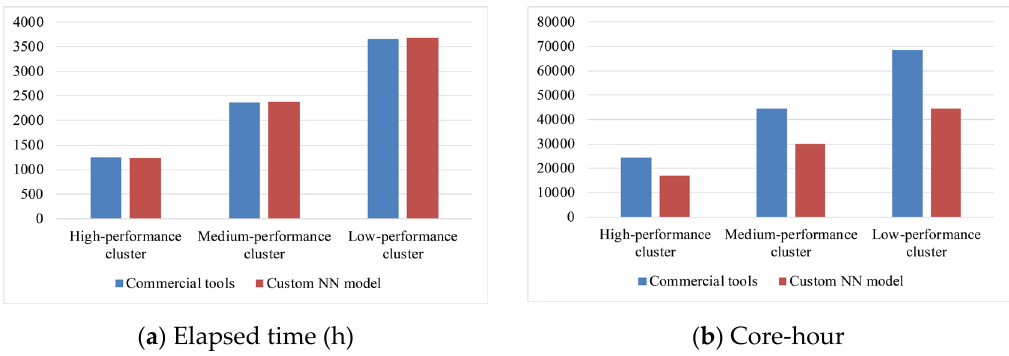
Figure 8. Resource consumption of the test dataset in various environments.